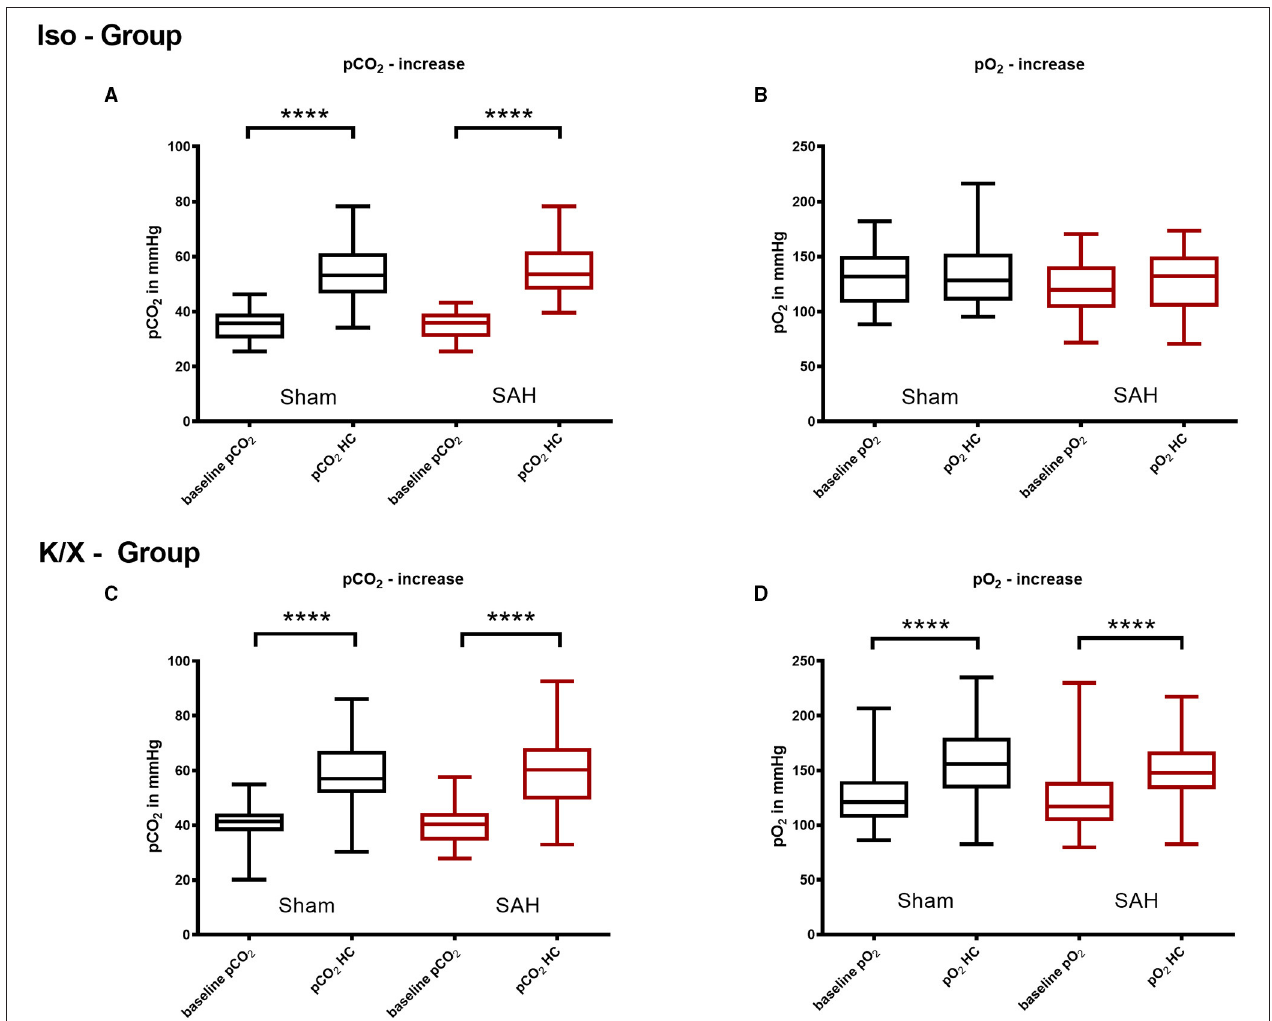
FIGURE 3 | Arterial pCO 2 and pO 2 analysis in hypercapnia periods. Blood gas analysis was performed before and during hypercapnia. In the Iso—Group there was a significant pCO 2 increase during hypercapnia (A) , while pO 2 did not change significantly (B) ; during hypercapnia, both pCO 2 (C) and pO 2 (D) increased significantly in the K/X—Group; SAH, subarachnoid hemorrhage; Iso, isoflurane; K/X, ketamine/xylazine; HC, hypercapnia; boxes show median and 25 and 75% percentile and whiskers show data range; **** p <